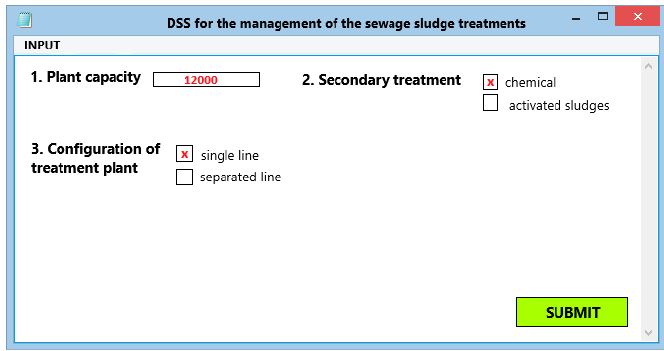
Figure 7. Screenshot of the VBA input query interfaced with the ANN model.